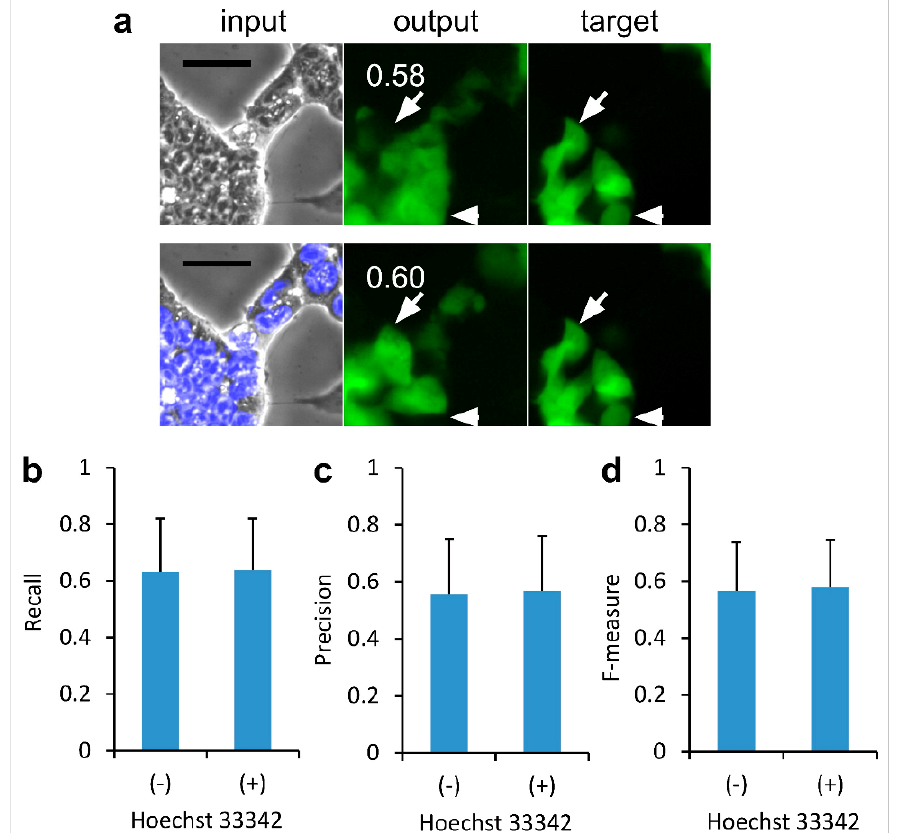
Figure 1. Comparison of the output of cancer stem cell (CSC) images between artificial intelligence (AI) models trained in the presence and absence of cell nucleus images. ( a ) Output example of AI models. The test input image of phase contrast with or without Hoechst 33342 was subjected to depiction as a fluorescence image. Scale bars = 100 µ m. The number in the output represents the F-measure value. The output image was compared with each target: ( b ) recall, ( c ) precision, and ( d ) F-measure. Mean ± S.D., n =